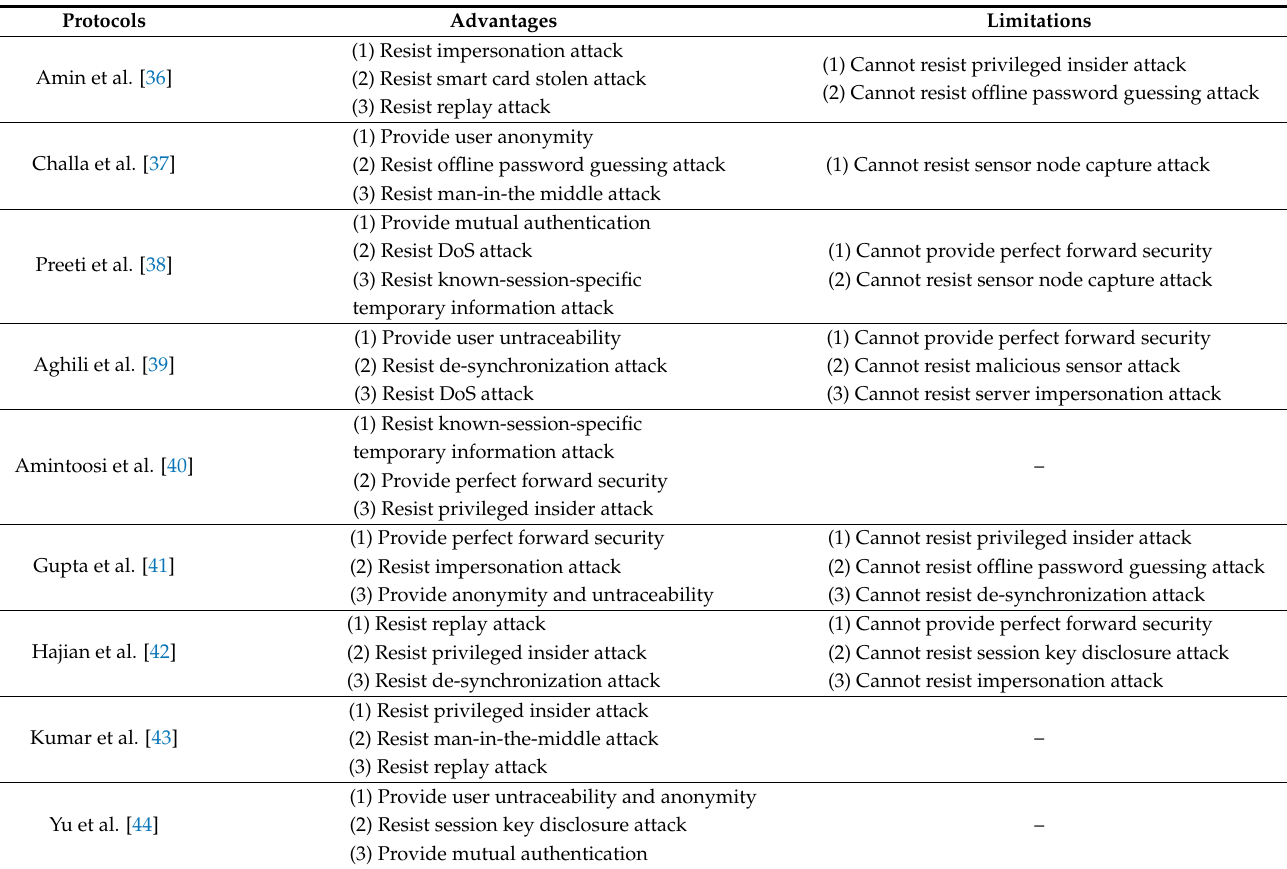
Table 1. A summary of the application of the Internet of Things in the medical industry. Protocols